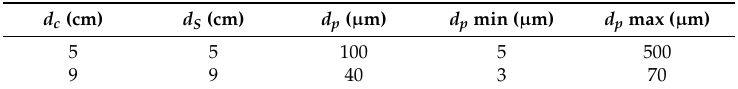
Table 2. Bubble column characteristics.